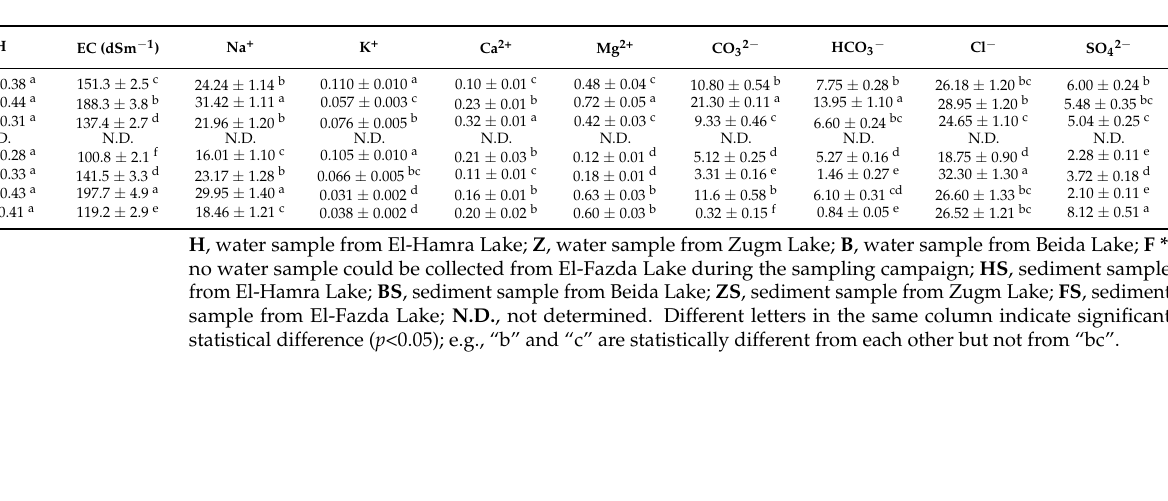
Table 2. Physicochemical analysis of water and sediment samples collected from soda lakes of Wadi